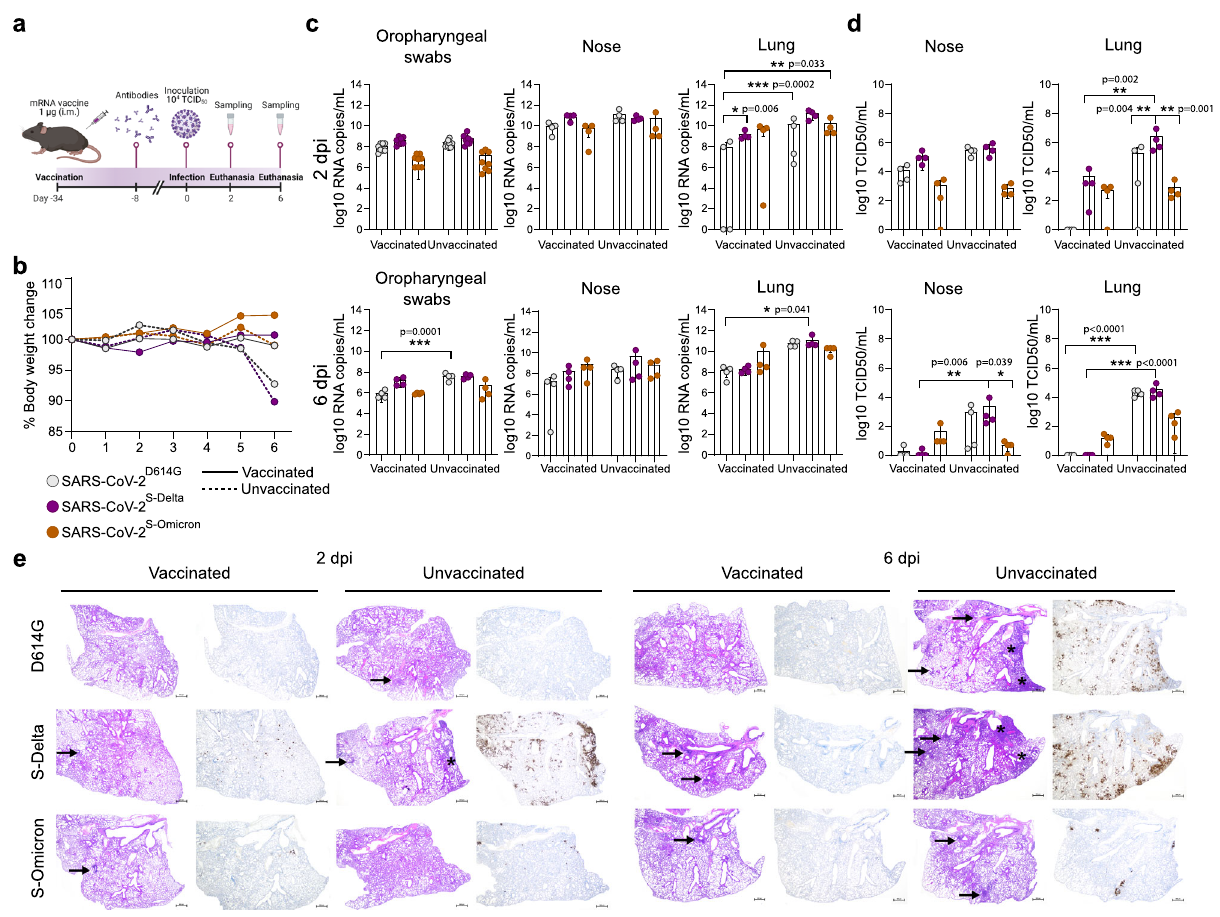
Fig. 4 | mRNA vaccine induced reduction in replication and pathogenesis of SARS-CoV-2 clones in K18-hACE2 transgenic mice. a Female K18-hACE2 trans- genic mice (7 – 15weeks old, n =8 mice/group) were immunized intramuscularly with a single dose of 1 μ g of mRNA-Vaccine Spikevax (Moderna). After 2weeks the neutralizing antibody titers against SARS-CoV-2 were determined (Supplementary Fig. 10a). Later, mice were intranasally inoculated with 10 4 TCID 50 of SARS-CoV- 2 D614G , SARS-CoV-2 S-Delta , or SARS-CoV-2 S-Omicron . Body weight change and clinical scores of the mice were monitored daily. b The mean body weight change is pre- sented (Data from individual animals are shown in Supplementary Fig. 10b). Only the unvaccinated mice infected with SARS-CoV-2 D614G and SARS-CoV-2 S-Delta showed noticeable weight loss. c Oropharyngeal swabs, lung and nose samples of the infected mice were collected at 2 or 6days post-infection (dpi) to determine the